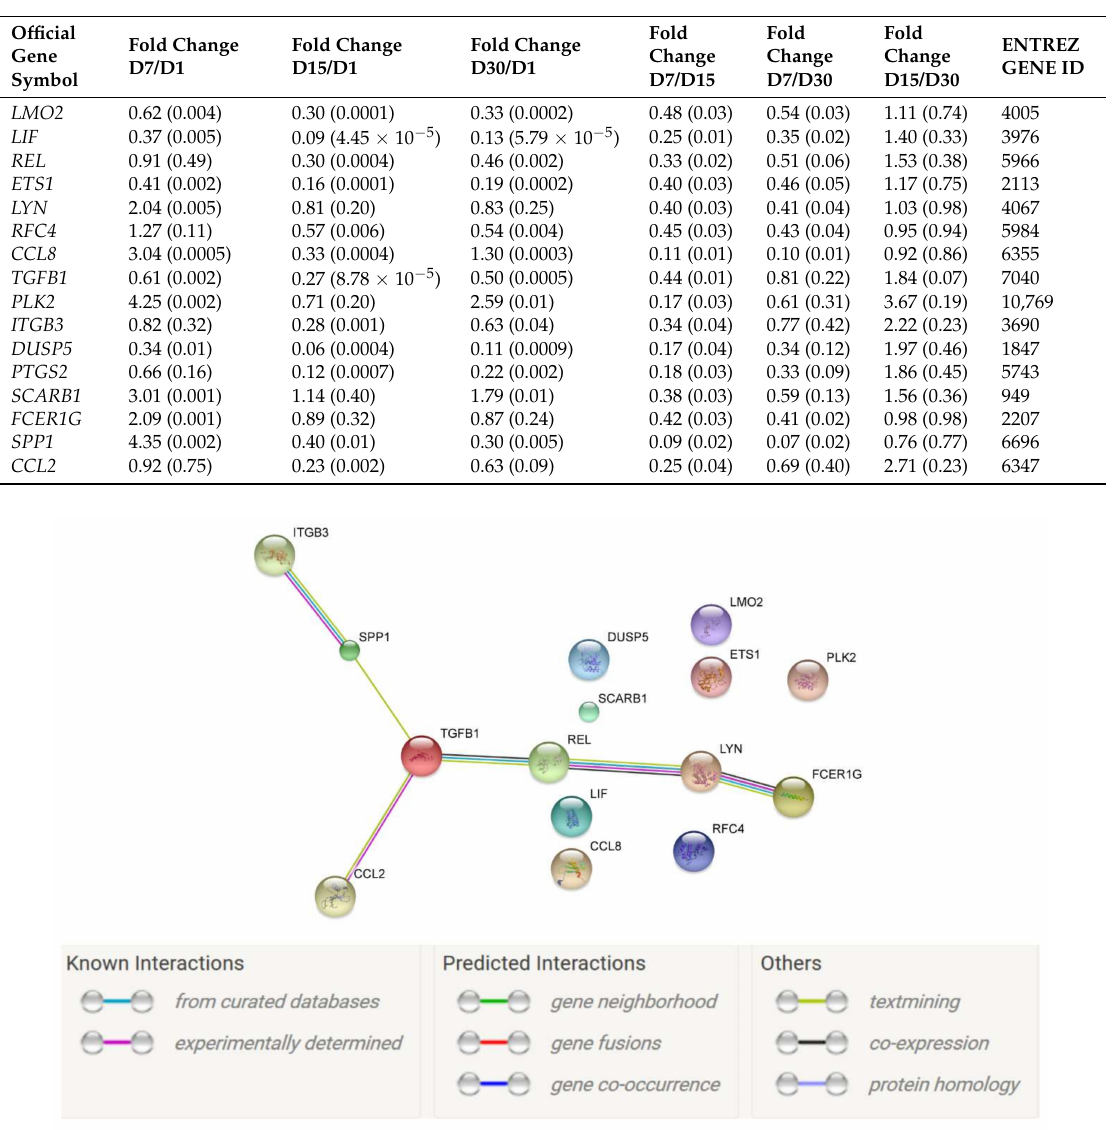
Figure 3. STRING (Search Tool for the Retrieval of Interacting Genes/Proteins)-generated interaction network among differentially expressed genes belonging to the “positive regulation of metabolic process” and “regulation of homeostatic process” GO BP terms. The intensity of the edges reflects the strength of interaction